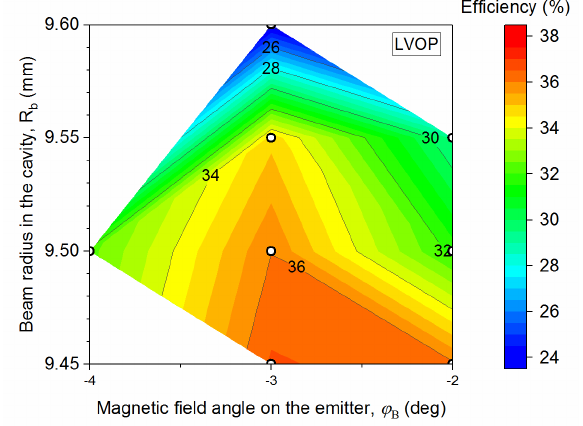
Fig. 8. Total efficiency with respect to the magnetic field angle at the emitter and the radius of the electron beam in the cavity. Operation at the